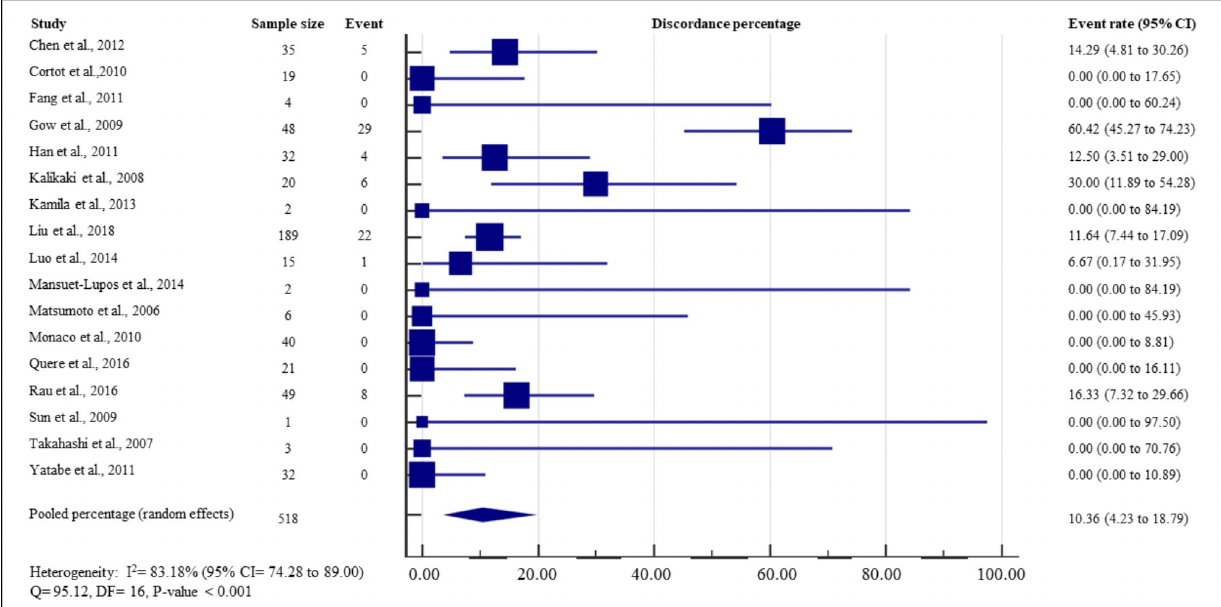
Fig 2. Study-specific and pooled estimate for EGFR mutation discordance percentages. Heterogeneity was assessed using I 2 and Q test. Event was defined as discordance of EGFR mutation status between primary lung tumor and paired metastases. Abbreviation: DF = degree of freedom; CI = Confidence interval; EGFR = epidermal growth factor